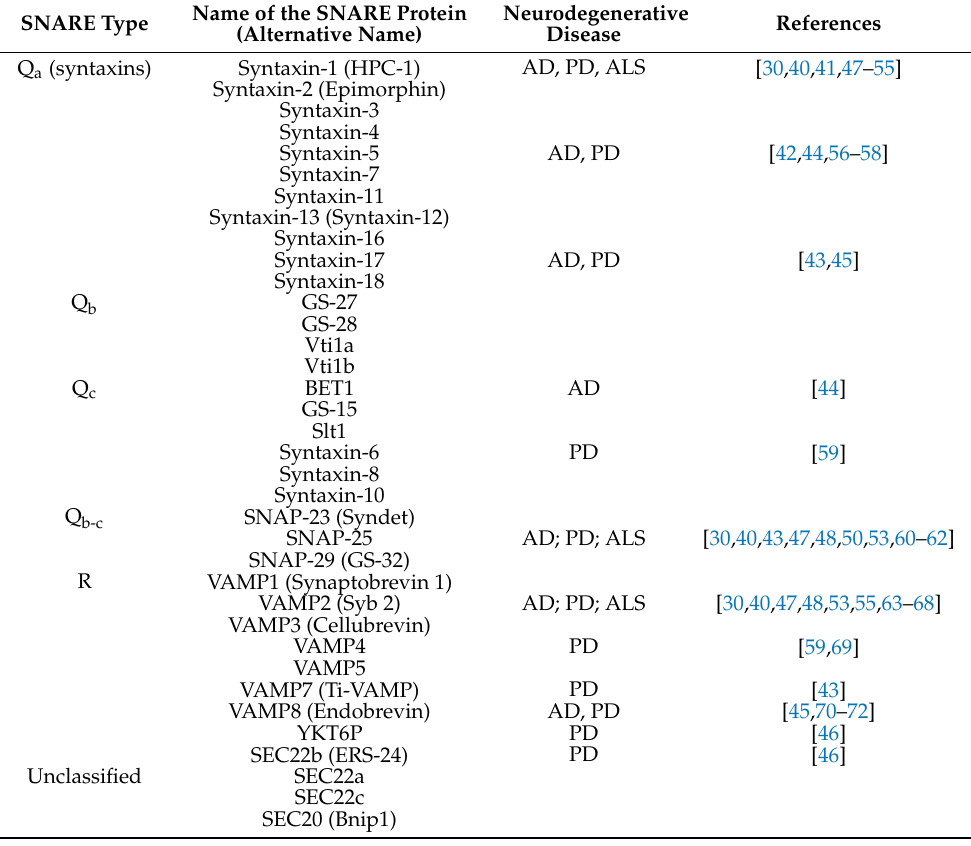
Table 1. Classification of human SNAREs and their involvement in neurodegenerative diseases.